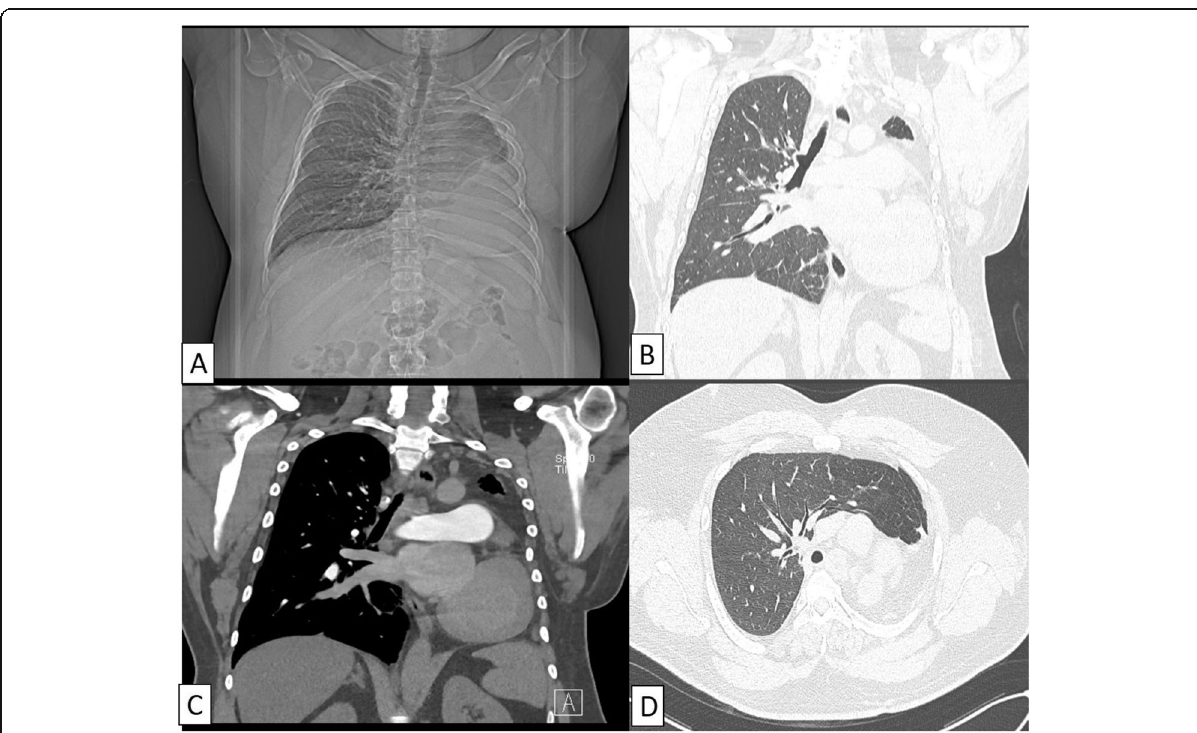
Fig. 2 CT topogram ( A ) showing homogenous opacity of left hemithorax with non-bifurcation of trachea with mediastinal shift and contralateral herniation of right lung. CT images in coronal lung window ( B ), coronal mediastinal window ( C ), and axial lung window settings ( D ) showing absent left lung with shift of mediastinal structures into left